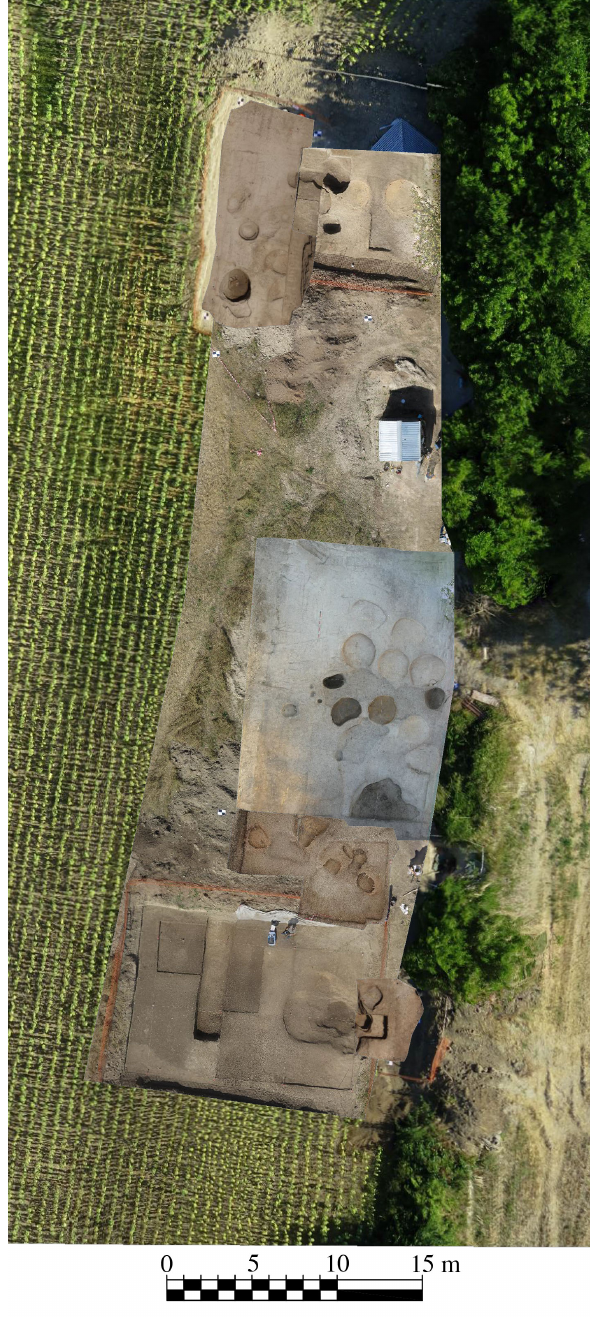
Figure 8: Ortophoto mosaic of the whole site, achieved with the completion survey by UAV